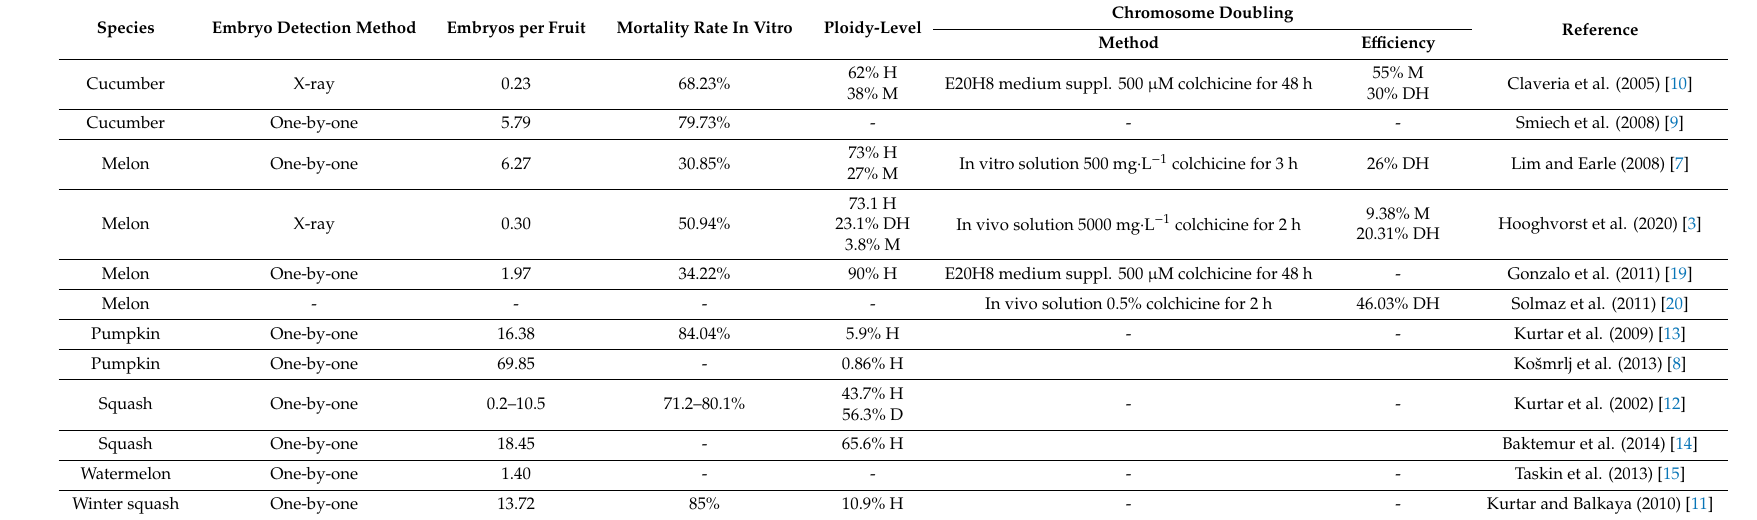
Table 1. Summary of the parthenogenetic methodology and e ffi ciency in cucurbit species for doubled haploid (DH) line